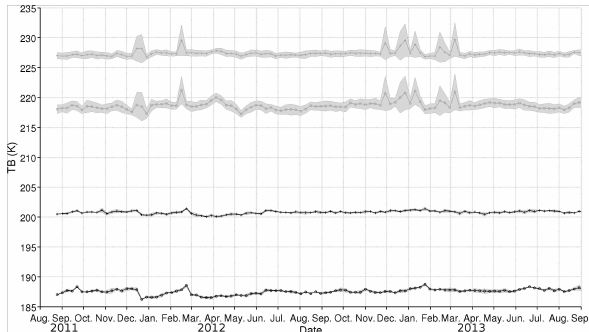
Fig. 7. Time series TB (radiometer 1) at V ( + ) and H (o) polarizations over Dome C (black), and Mary Byrd land (gray). The gray envelop corresponds to the weekly TB standard deviation. 32